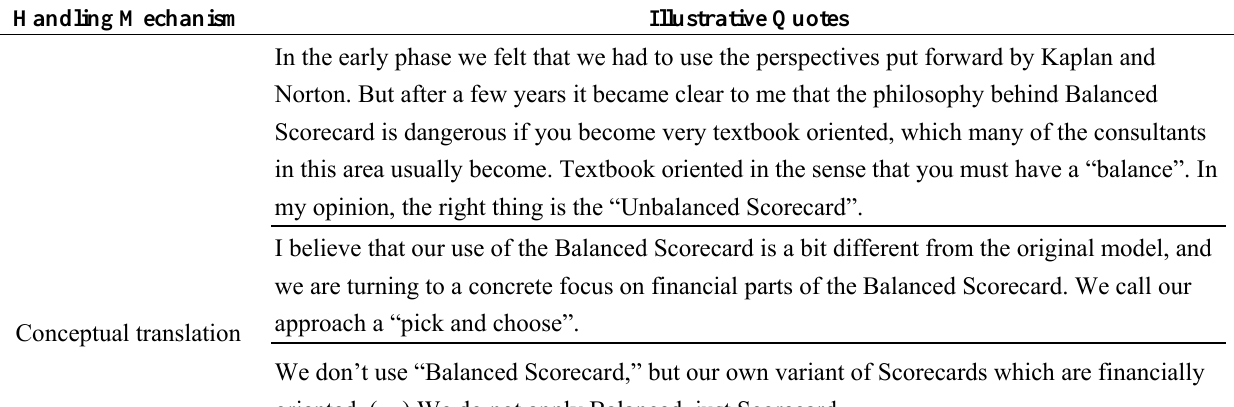
Table 11. Mutation of the